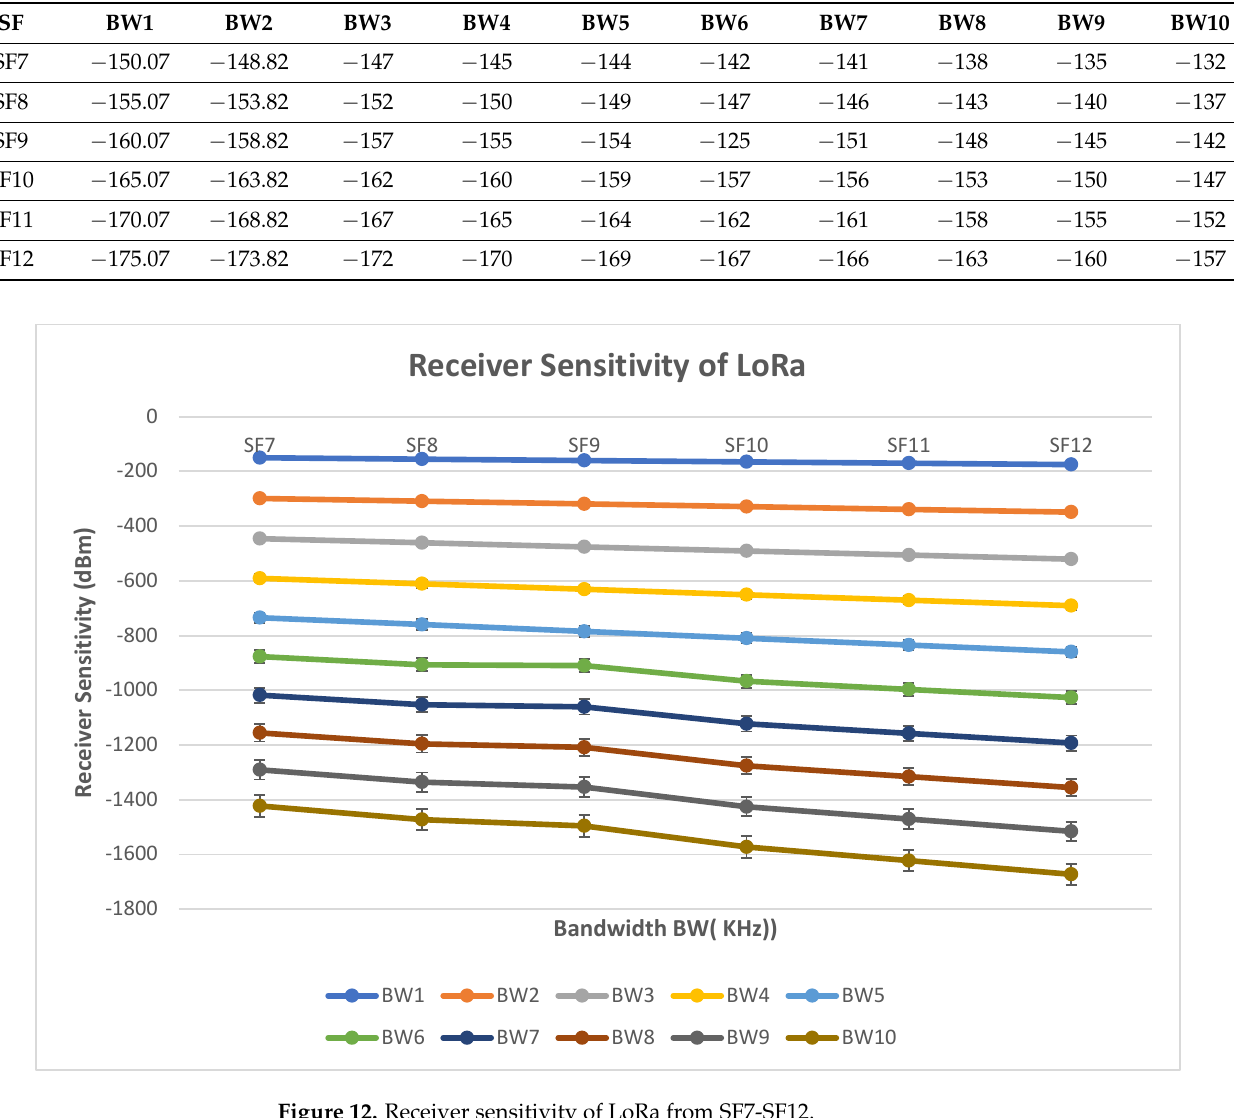
Figure 12. Receiver sensitivity of LoRa from SF7-SF12.